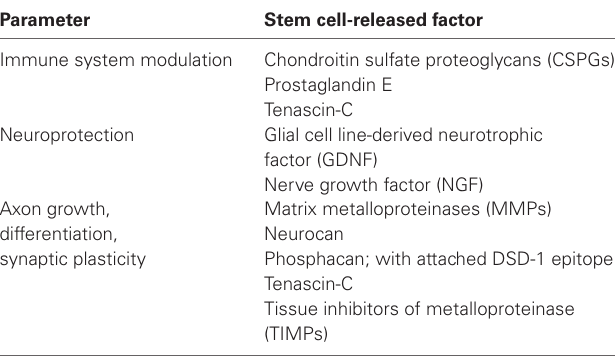
Table 3 | Aspects potentially influenced by transplanted stem cells .